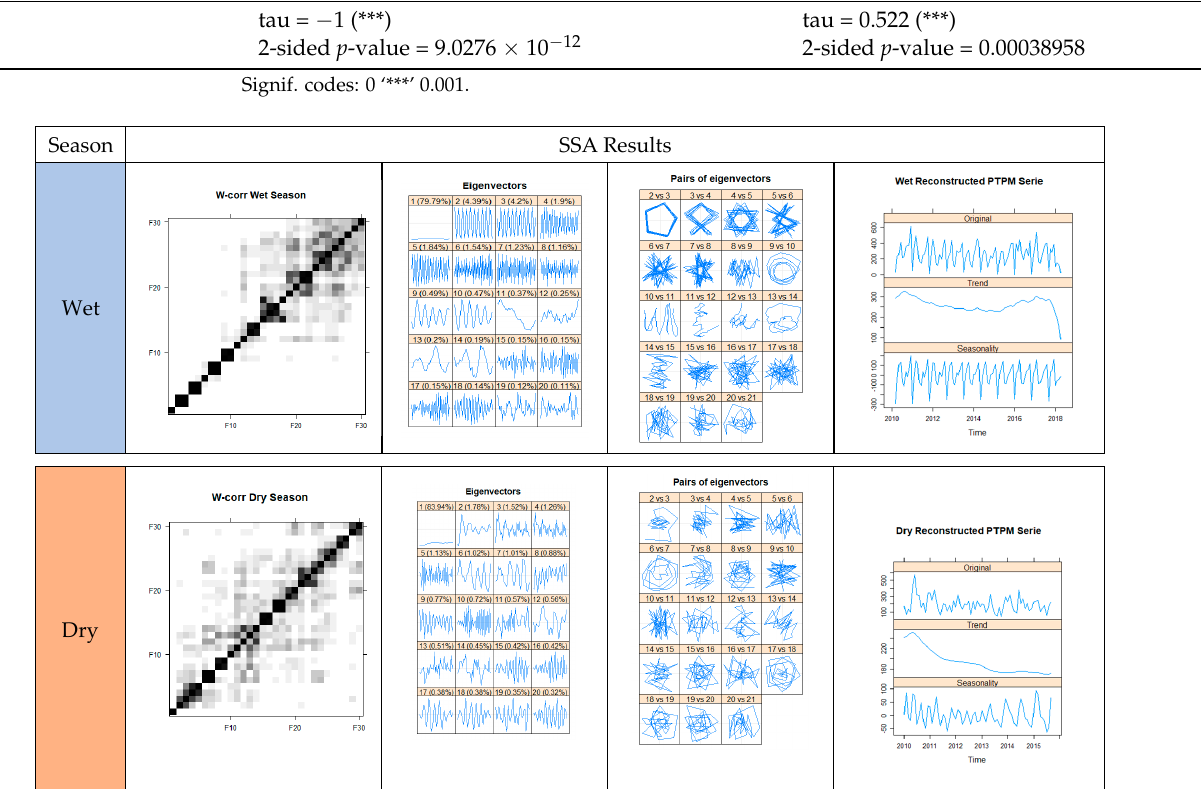
Figure A1. SSA analysis of PTPM time series for the first component. Source: author’s processing. Notes: These images aid in deriving the tendency and seasonality signal components from a win- dow length of = N/2. The first column depicts the w-correlation plots for wet and dry seasons, which lets us assess the strength of separability, as shown by the pairs that are separated from each other and those that are contaminated by noise. The second column shows the eigenvectors useful to identify through their form, tendency, and seasonal components. The third column identifies the pair of eigenvectors to be chosen by those who form regular polygons. Note: selected vectors: wet: trend = (1,11,12), seasonality = (6:7, 8:9). For dry: trend = (1), seasonality = (6:7, 8:9).